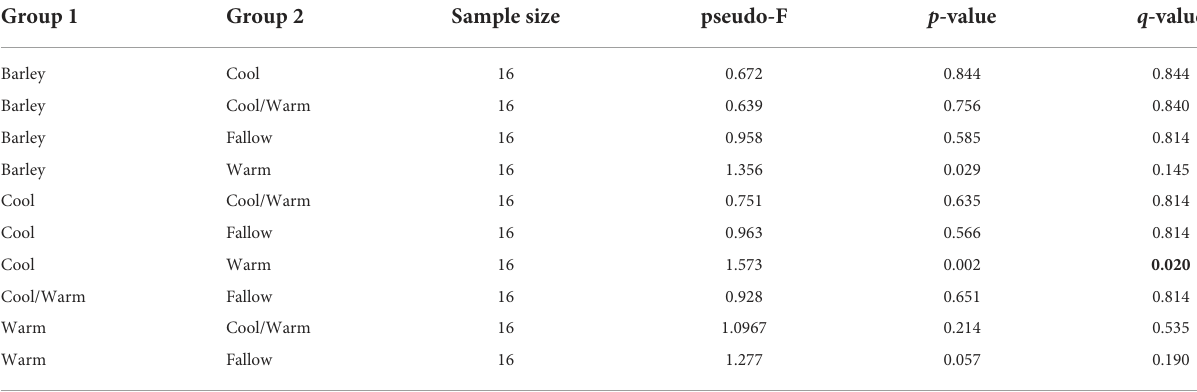
TABLE 3 Pair-wise permutational analysis of variance (PERMANOVA) for multivariate ( β -diversity) group significance for cover crop treatments. Group 1 Group 2 Sample size pseudo-F p -value q